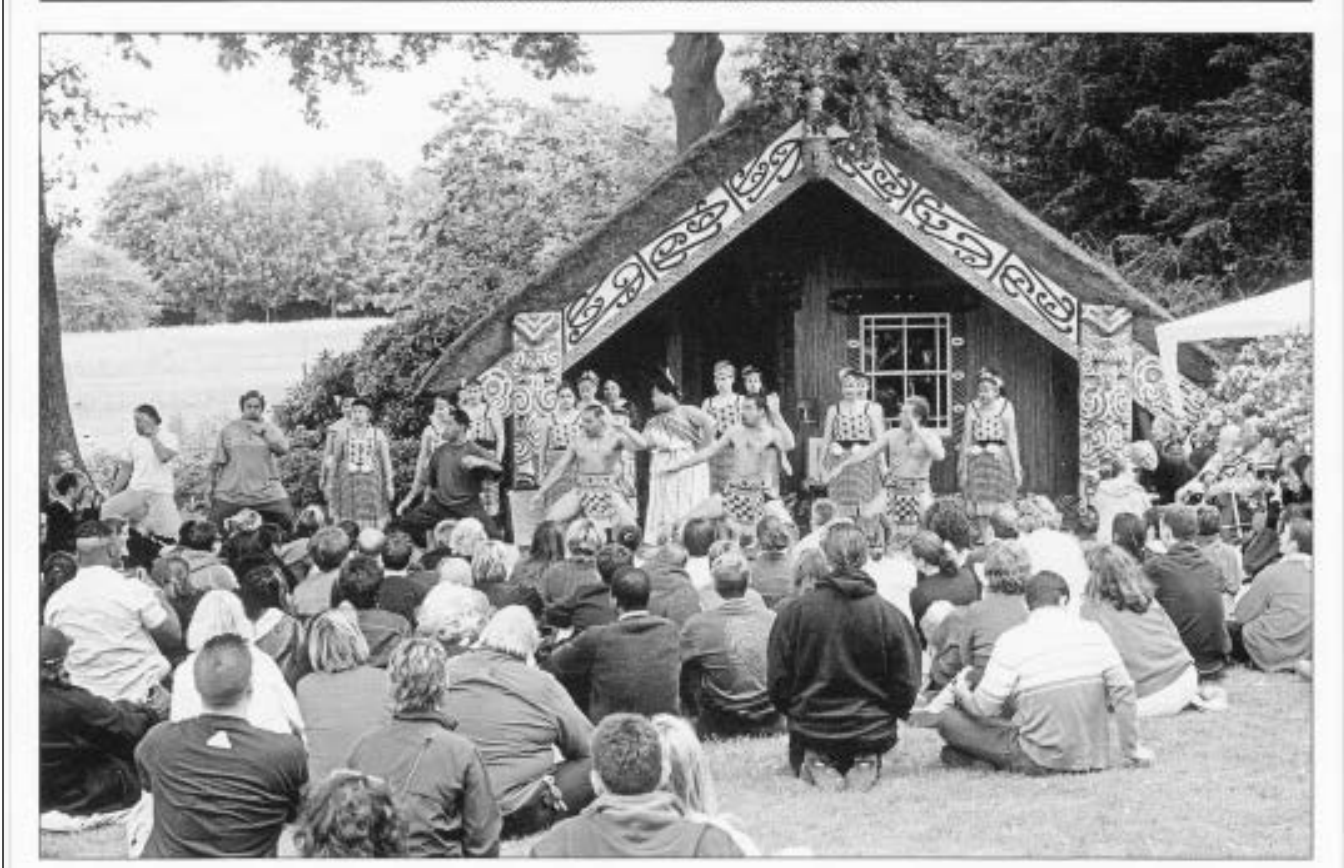
Figure 7 Hinemihi at Cl and on Park in June 2003 during the annual hangi of London-based Kohanga